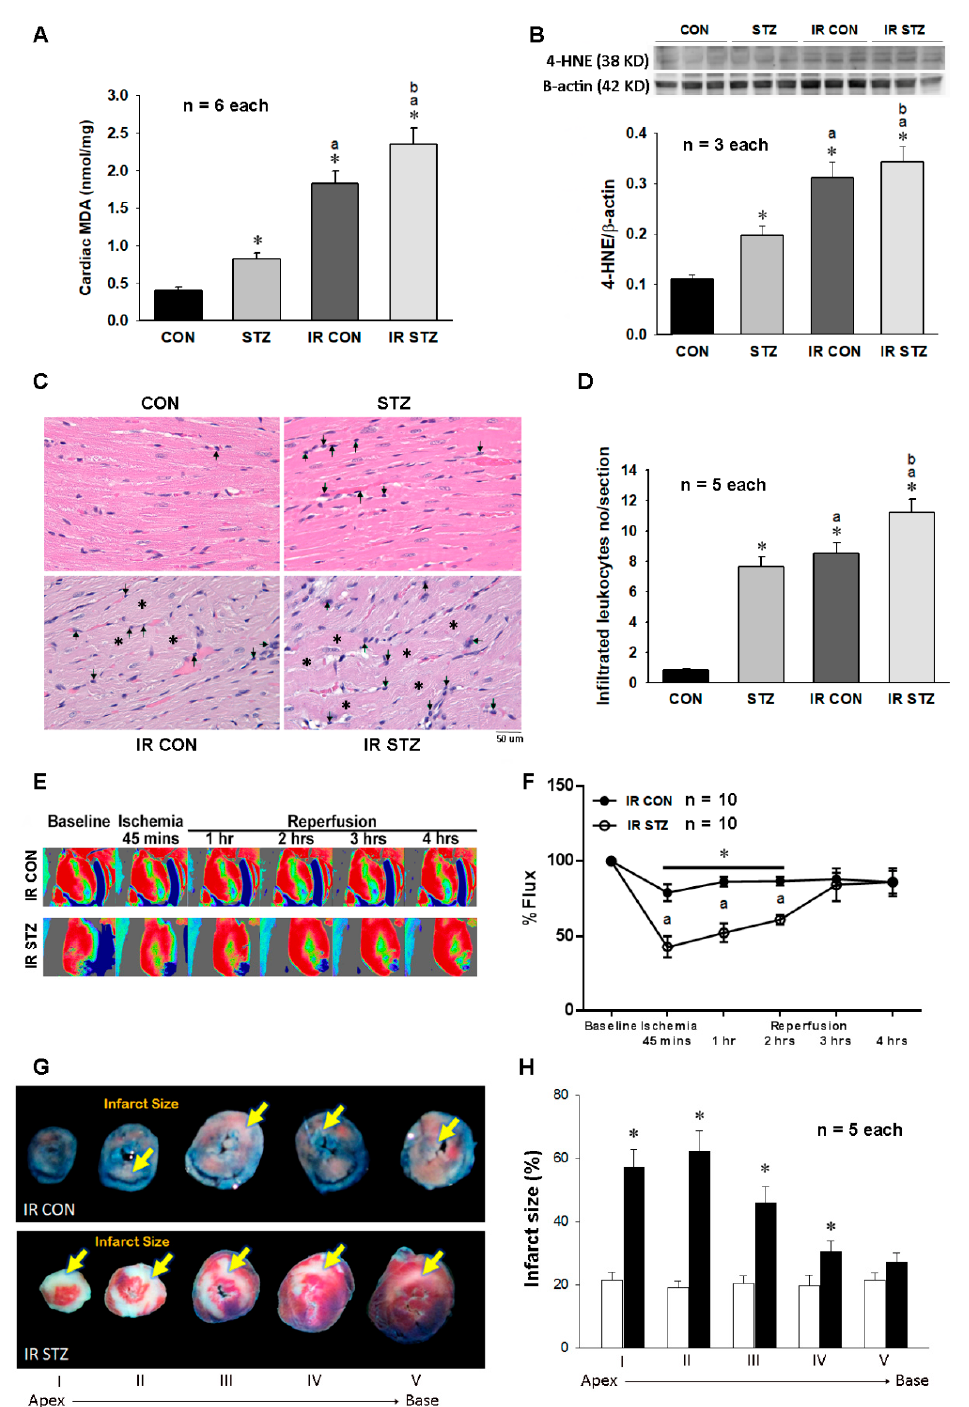
Figure 5. The diabetes effect on IR affected cardiac lipid peroxidation in MDA content ( A , n = 6), 4-HNE expression ( B , n = 3), leukocyte infiltration and cardiac structure ( C , D , n = 5), microcirculation ( E , F , n = 10) and infarct size ( G , H , n = 5) in IR CON and IR STZ rats. Data are expressed as mean ± SEM. In graph C, the arrow indicates the infiltrated leukocyte and the star indicates cardiac structural alteration. * p < 0.05 vs. CON, a p < 0.05 vs.